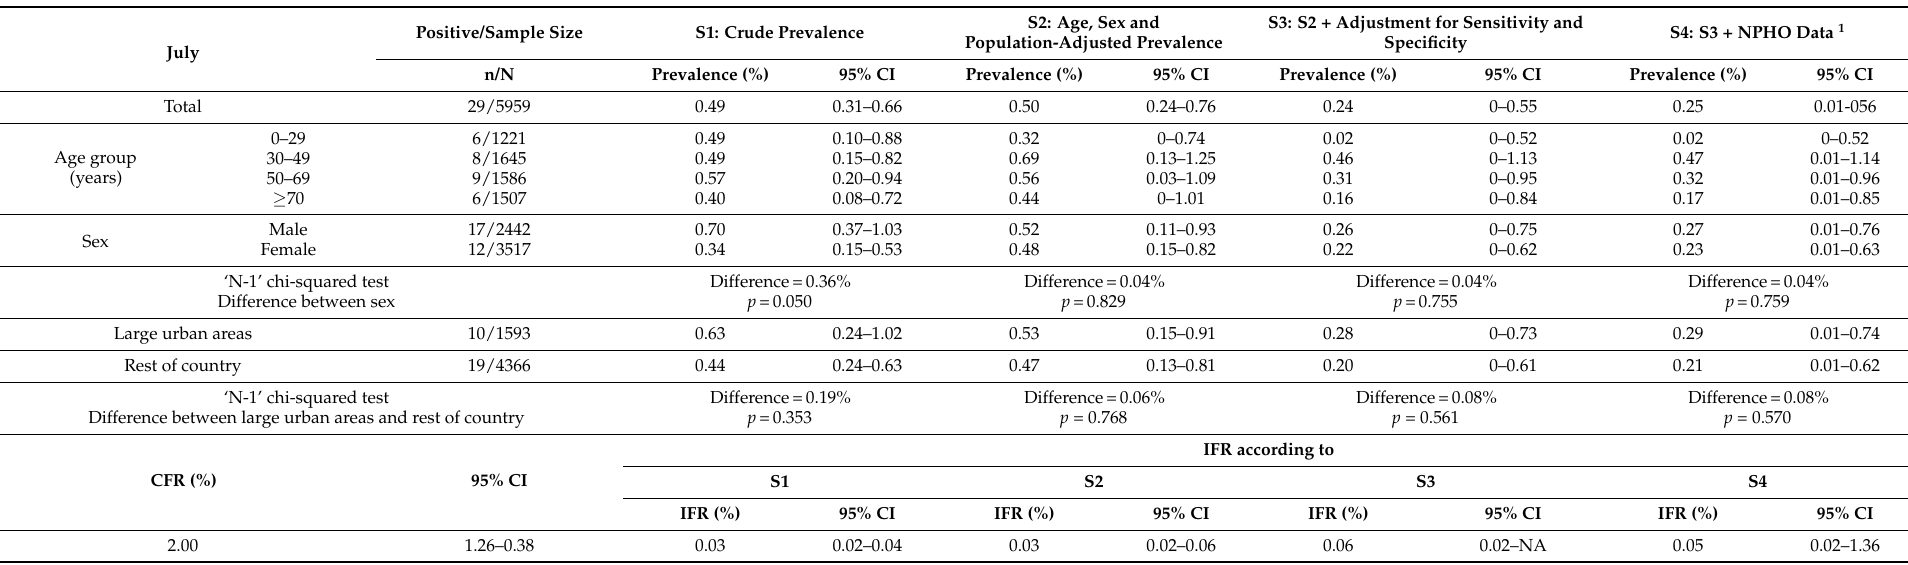
Table 3. Anti-SARS-CoV-2 IgG antibody seroprevalence, Greece, July 2020 ( n =